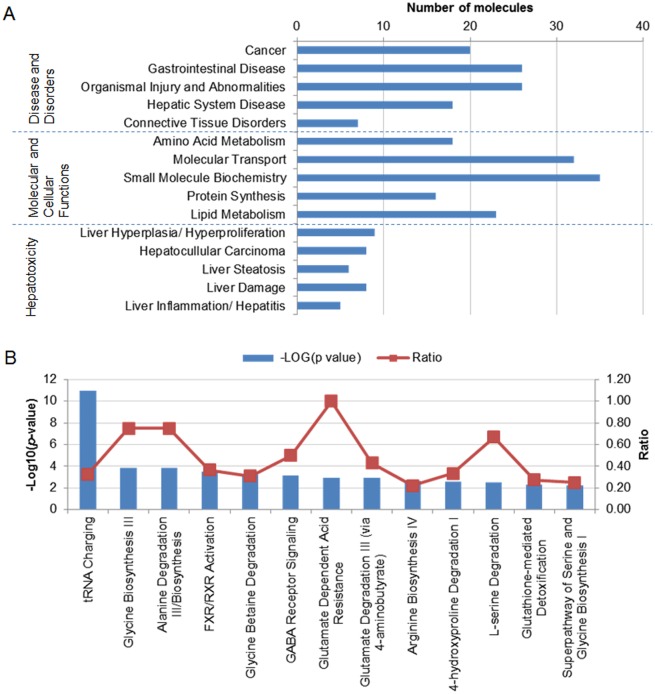
Effects of the metabolic alteration on Disease and Bio Functions and Tox Functions predicted by IPA (p<0.05).(A) The top five entries in three aspects of biological impact: Disease and Disorders, Molecular and Cellular Functions, and Hepatotoxicity. (B) Top altered canonical pathways predicted by IPA (p<0.005). The p values were calculated using Fischer's exact test determining the probability that the association between the genes in the data set and the canonical pathway was due to chance alone. The ratios were calculated based on the number of genes from the data set that mapped to the pathway and the total number of genes in the pathway.